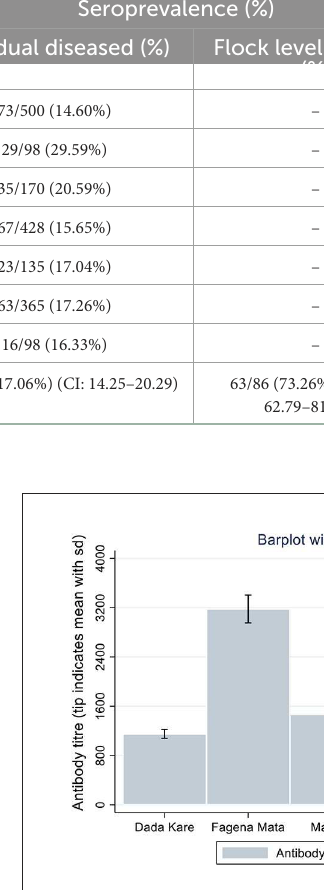
FIGURE1 Comparison of antibody response in different peasant association